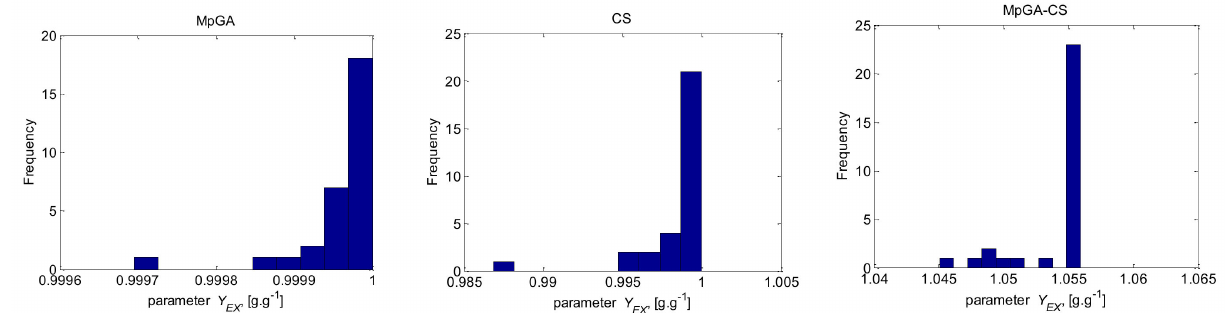
Figure 10. Histograms of the results for six model parameter estimates from parameter identification of S. cerevisiae FP model (30